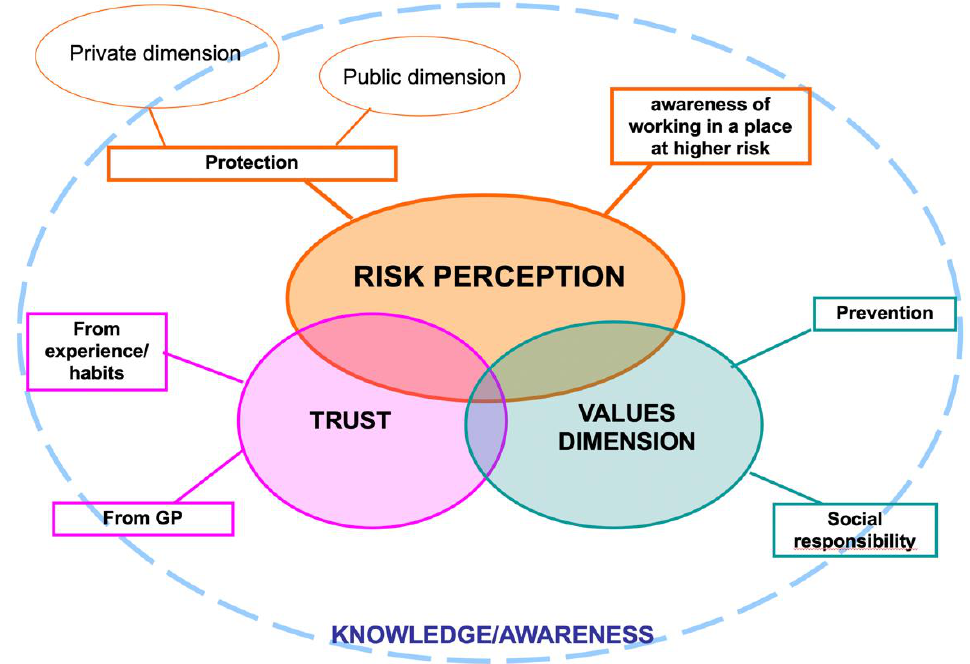
Figure 1. Links between macro-categories and sub-categories of reasons to get vaccinated.